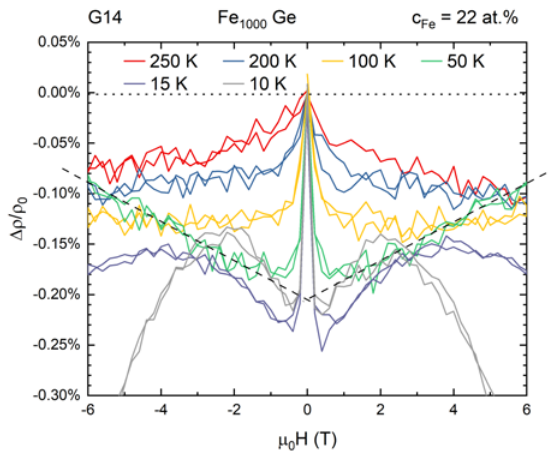
Figure 4. Set of magnetoresistance curves at different temperatures from sample G14. Intuitively, the magnetoresistance is a superposition of a sharp drop at low fields and a field-dependent component which is linear to good approximation above 40 K and non-linear below. The dashed lines approximate the high field magnetoresistance data at 50